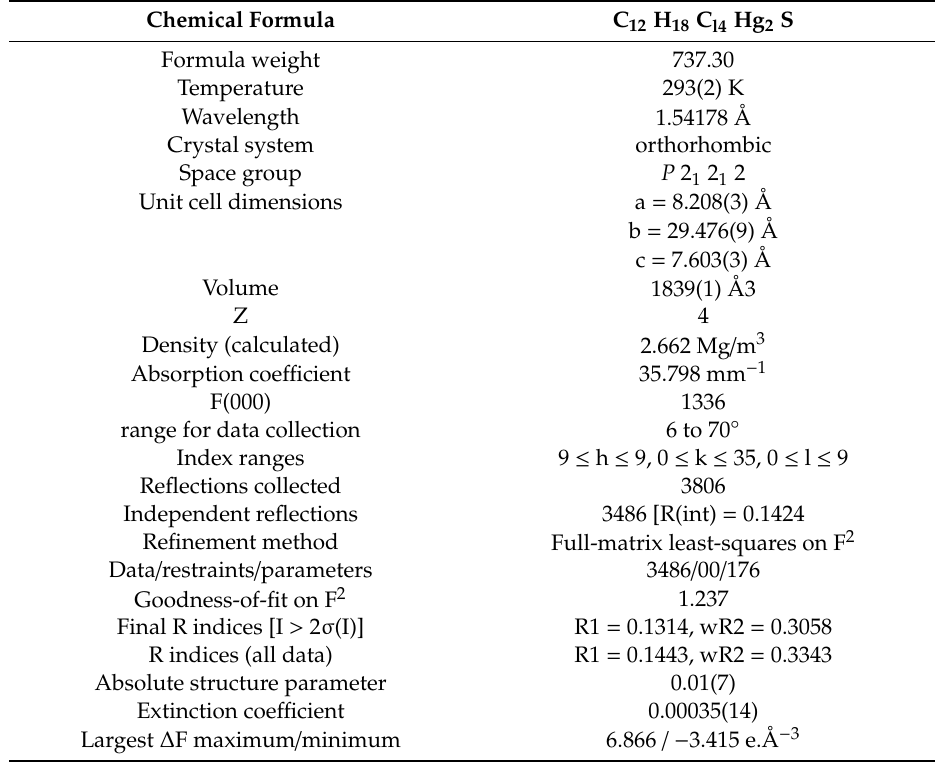
Table 1. Crystal data and structure refinement for ( II